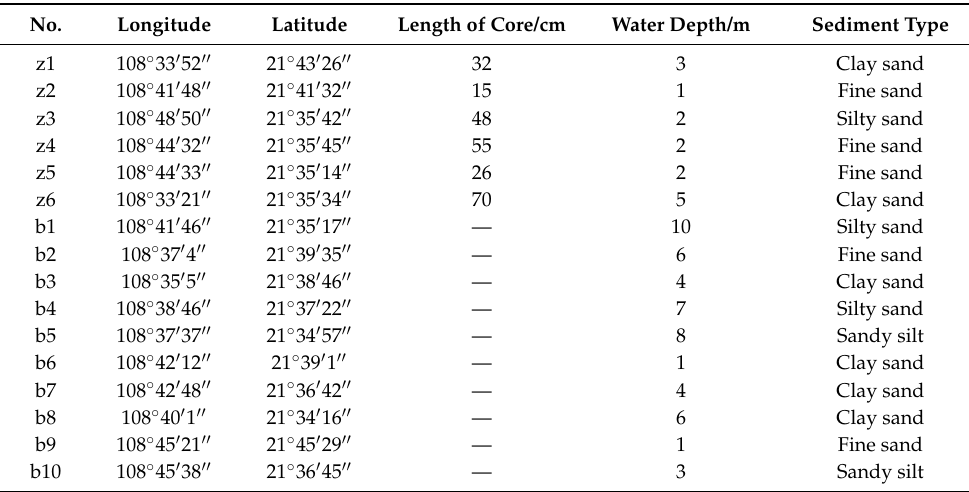
Table 1. Data of sediments collected in the research